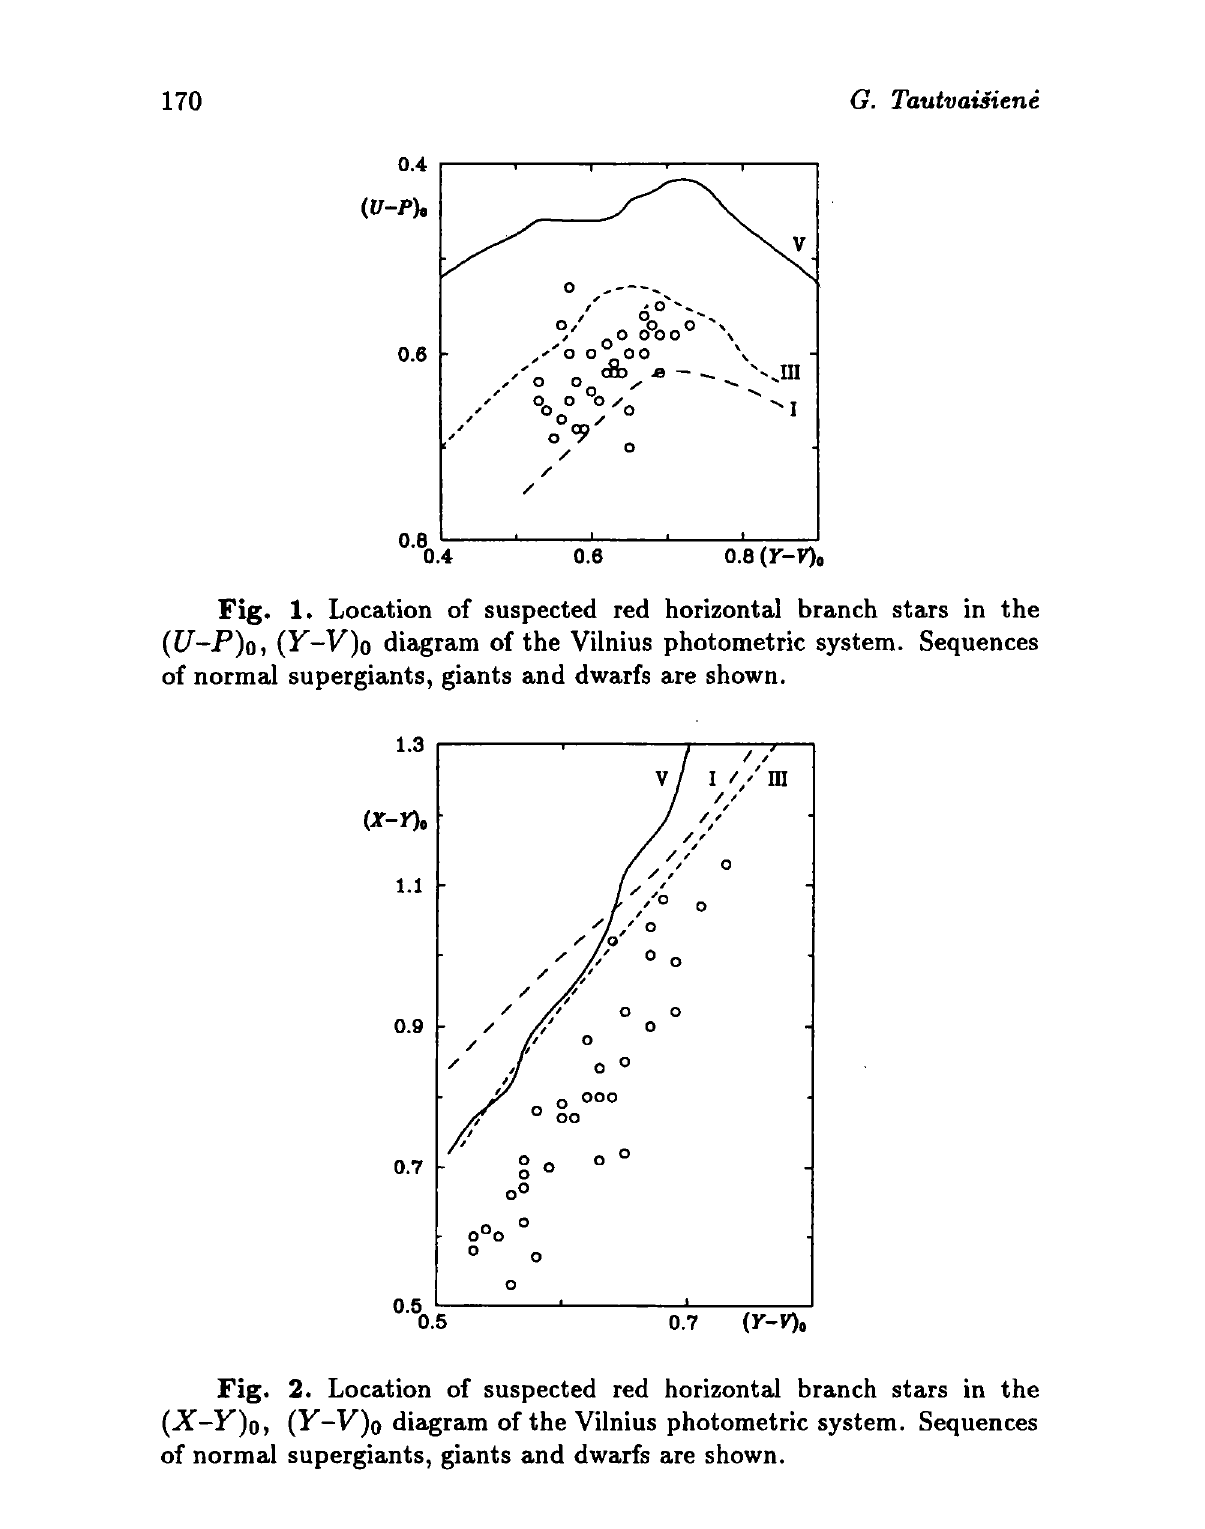
Fig. 2. Location of suspected red horizontal branch stars in the (X-K)o, (Y-V)o diagram of the Vilnius photometric system. Sequences of normal supergiants, giants and dwarfs are